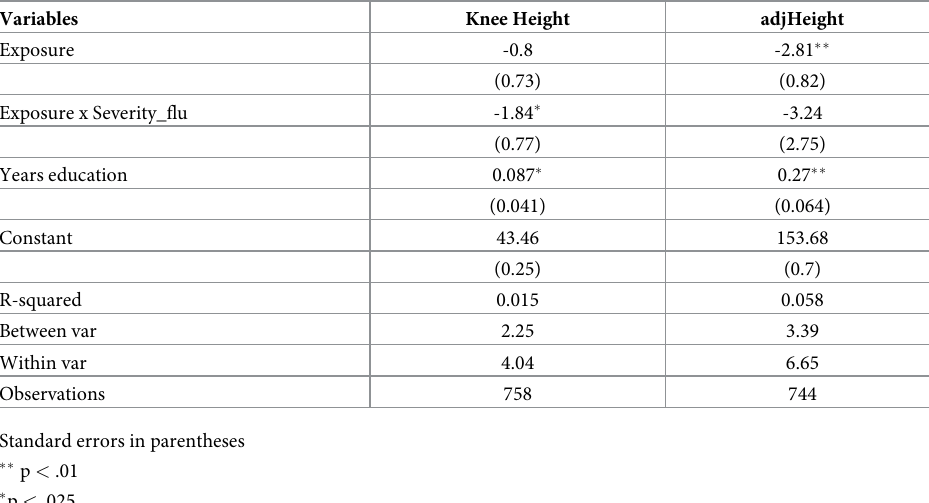
Table 5. Models with flu severity